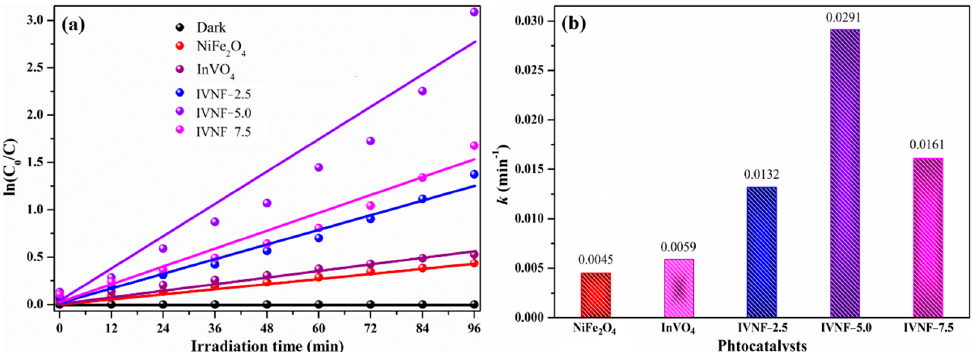
Figure 9. ( a ) Pseudo-first-order kinetics and ( b ) kinetic rate constants of the as-prepared catalysts.